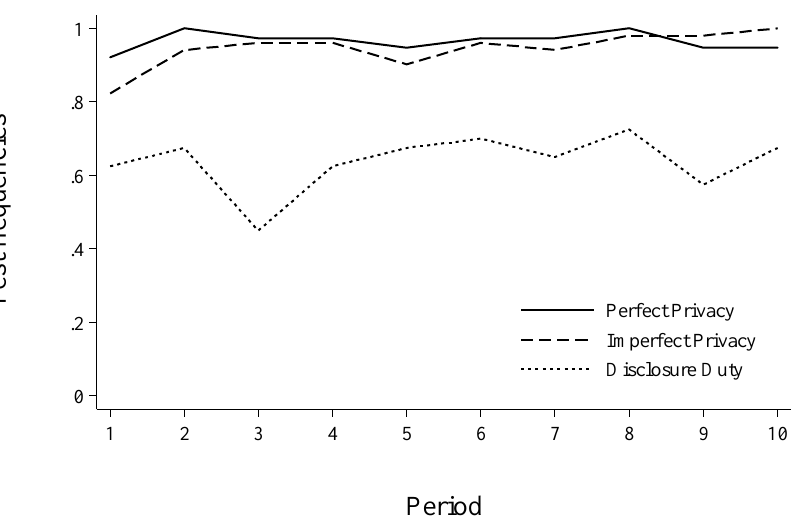
Figure 3. Test frequencies over periods across treatments (Part 2).